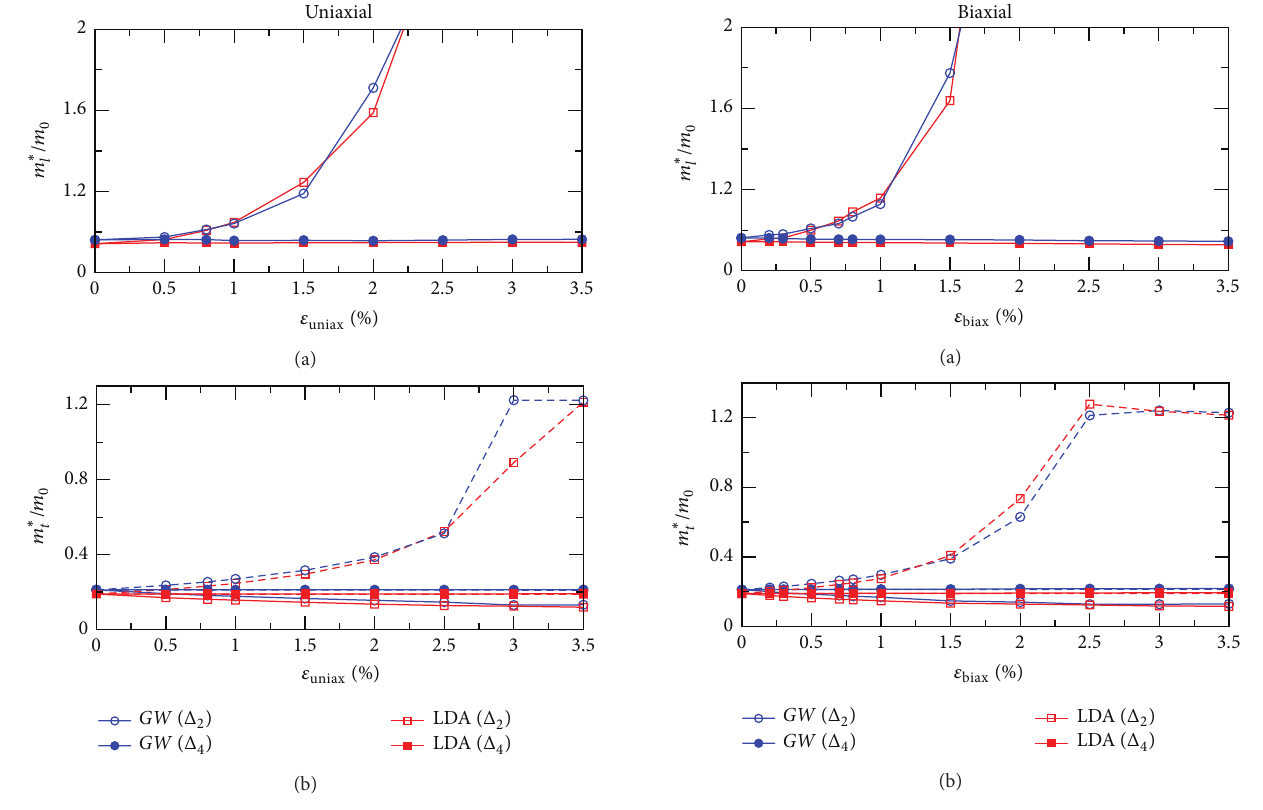
Figure 5: Longitudinal (a) and transverse (b) components of the electron effective mass in silicon as a function of tensile uniaxial strain in the [110] direction. The solid and dashed lines distinguish the two transverse elements of the mass tensor.